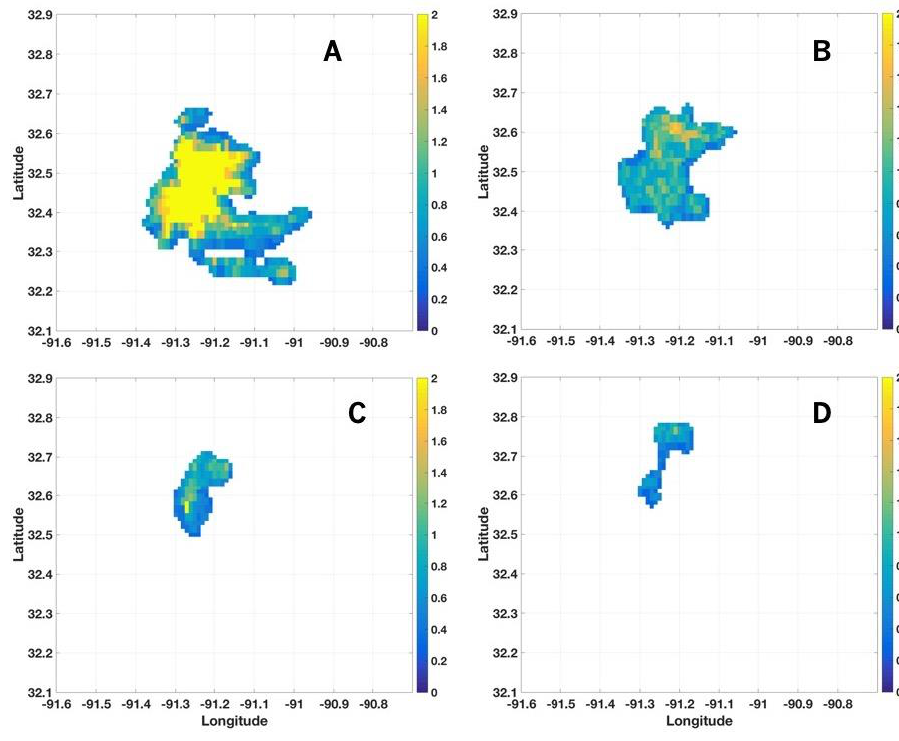
Figure 7. Example of one precipitation segment at ( A ) 𝑇 − 3 , ( B ) 𝑇 − 2 , ( C ) 𝑇 − 1 , and ( D ) T .